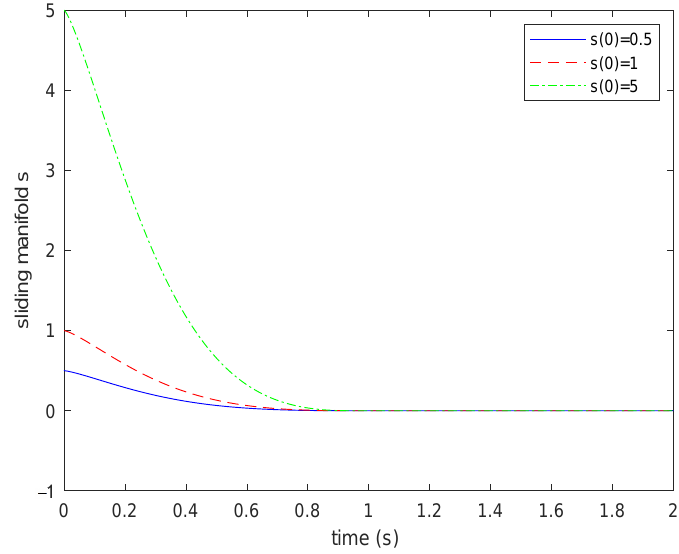
Figure 6. Sliding manifolds with reaching law (19) in Example